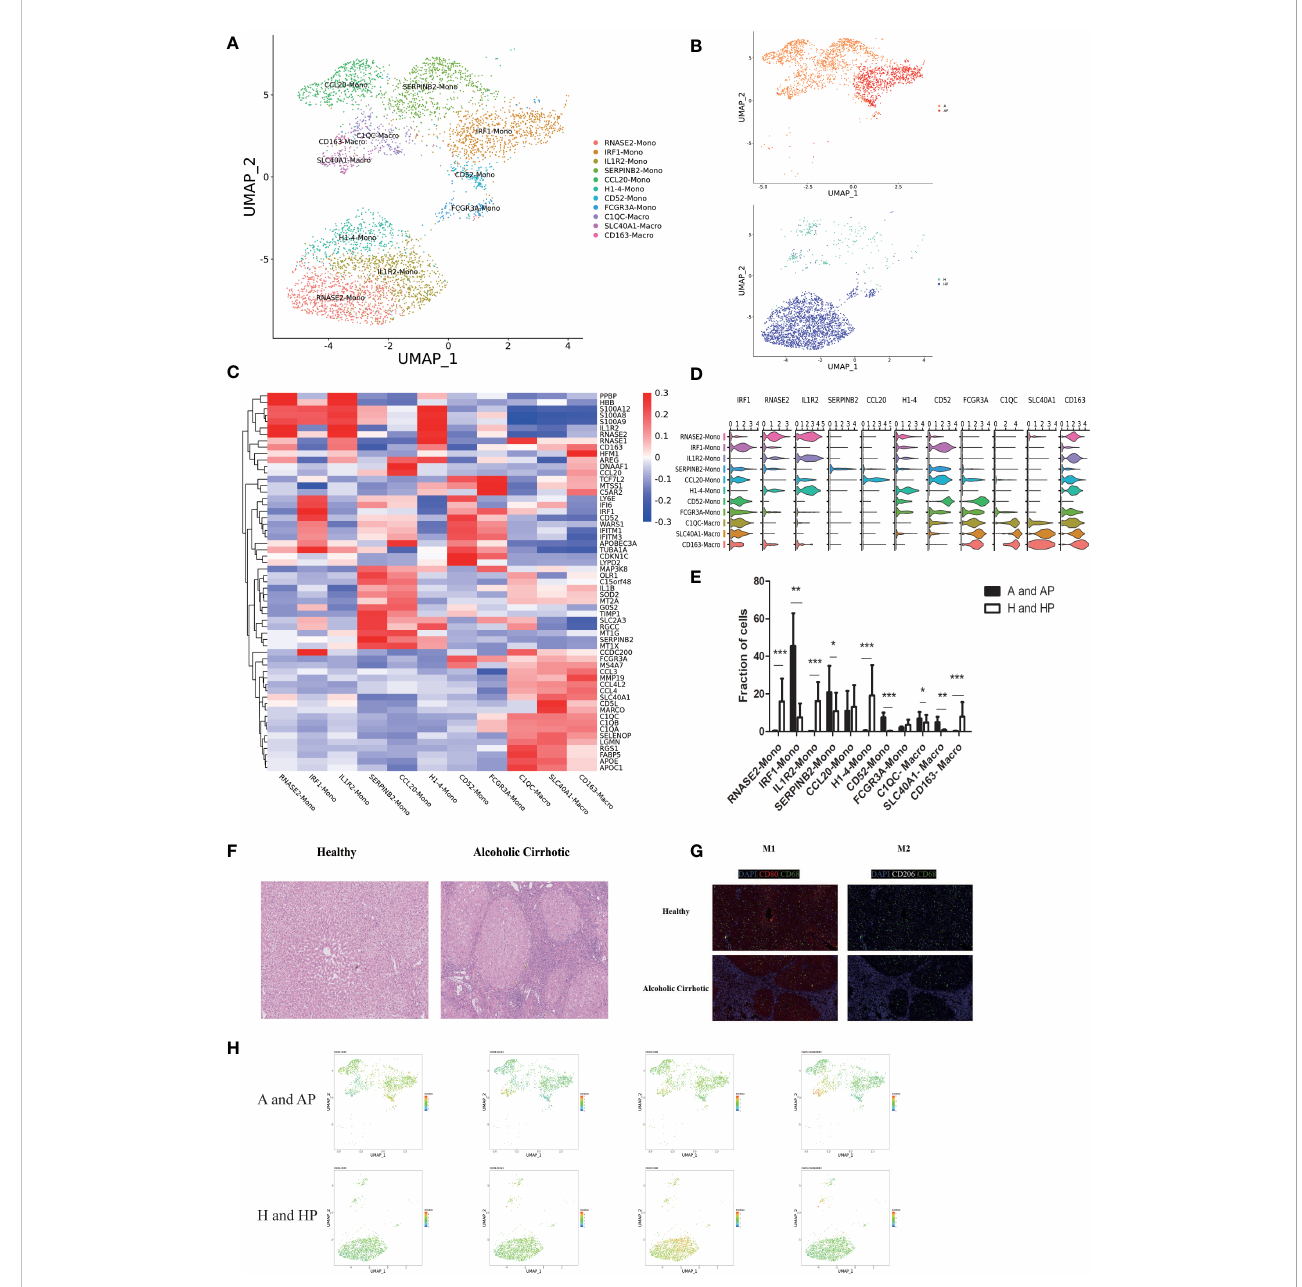
FIGURE 2 The monocyte and macrophage subpopulations. (A) Clustering of 5176 monocytes and macrophages from fi ve liver tissue and peripheral blood samples (n = 2 healthy and n = 3 alcoholic cirrhosis) (B) Annotation of monocytes and macrophages by patient ’ s condition. (C) Heatmap of MP cluster marker genes. (D) Scaled gene expression of monocytes and macrophages. (E) Fraction of monocyte and macrophage cells. (F) Pathological changes in the liver tissues of patients with alcoholic cirrhosis (10×). (G) Representative immuno fl uorescent images of CD80 (red), CD206 (white), CD68 (green), and DAPI (blue) in alcoholic cirrhotic livers (10×), and the distribution of M1 and M2 in healthy and alcoholic cirrhotic livers. (H) Proteomic analysis of CD80, CD52, CD163, and CD206. (*P < 0.05, **P < 0.01, ***P <